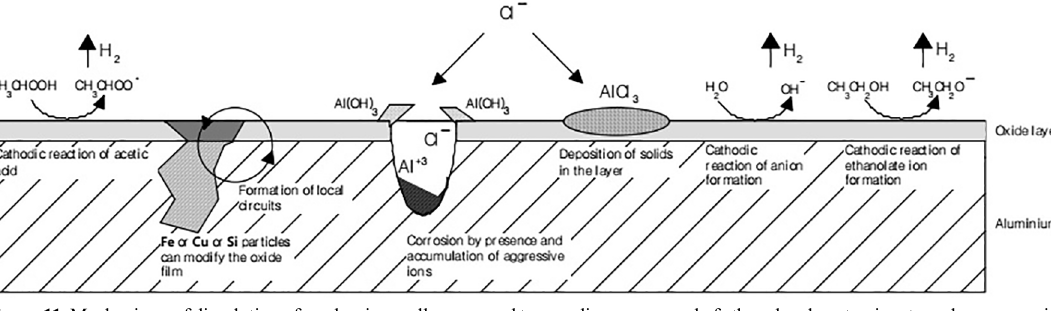
Figure 11. Mechanisms of dissolution of an aluminum alloy exposed to a medium composed of ethanol and contaminants such as aggressive ions, organic acids and water, according to the proposed mechanisms and references cited in the